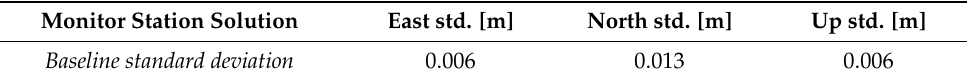
Table 10. Monitor station standard deviation during the jamming incident in Case 1.